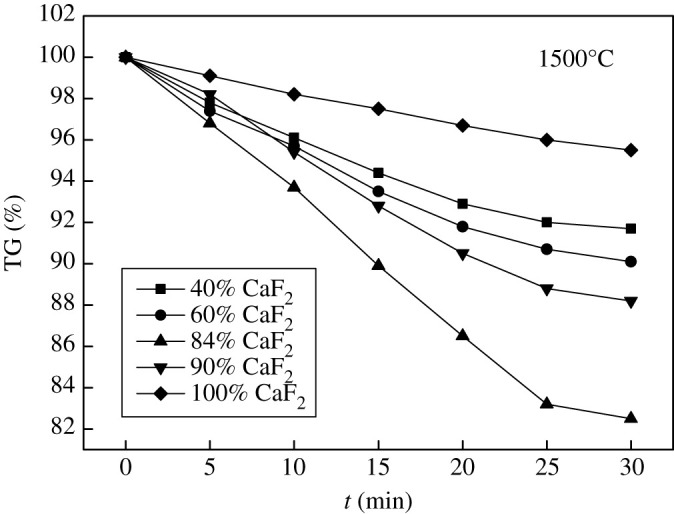
Effect of CaF2 on volatilization of refining slag.